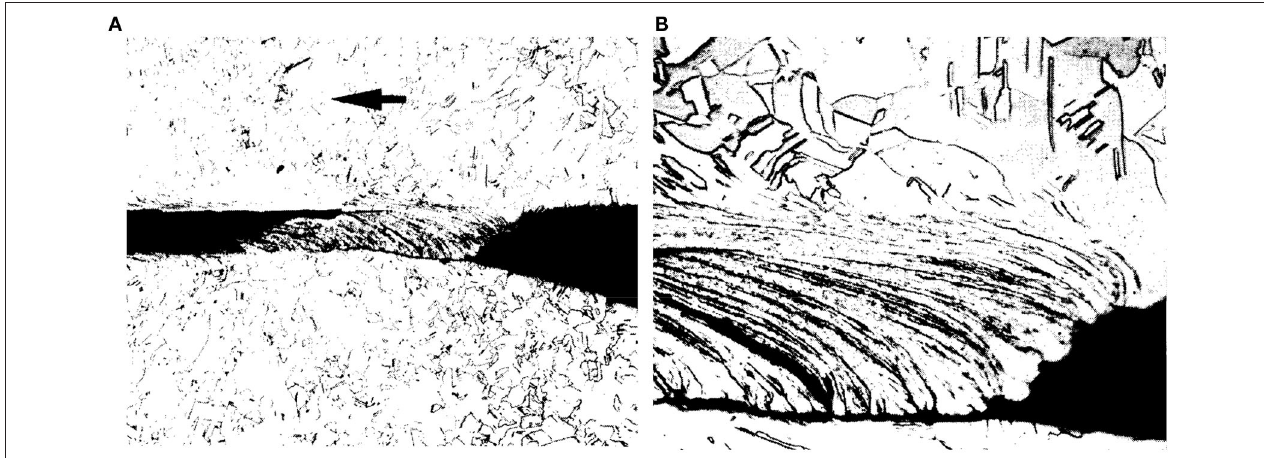
FIGURE 1 | Section through the wedge linking drum and rider, both of oxygen-free high-conductivity copper, after sliding at a speed of 0.038cm/s with a load of 710g. (A) Complete wedge. Magnification 100 × . (B) Right-hand portion of the section in (A) . Magnification 340 × [Reproduced from Cocks (1962), with the permission of AIP